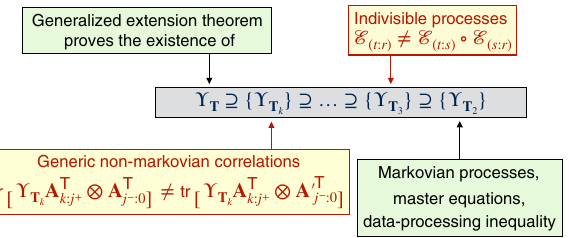
FIG. 24. Hierarchy of multitime quantum processes. A quan- tum stochastic process is the process tensor over all times. Of course, in practice one looks only at finite-time statistics. How- ever, the generalized extension theorem tells us that the set of } contain, as marginals, all j -time all k -time process tensors { ϒ T k } for j < k . Moreover, the set of probability distributions { ϒ T j two and three time processes plays a significant roles in the the- ory of quantum stochastic processes. Here, we display only a small part of the multifaceted structure of non-Markovian quan- tum processes. For a much more comprehensive stratification, see Refs.